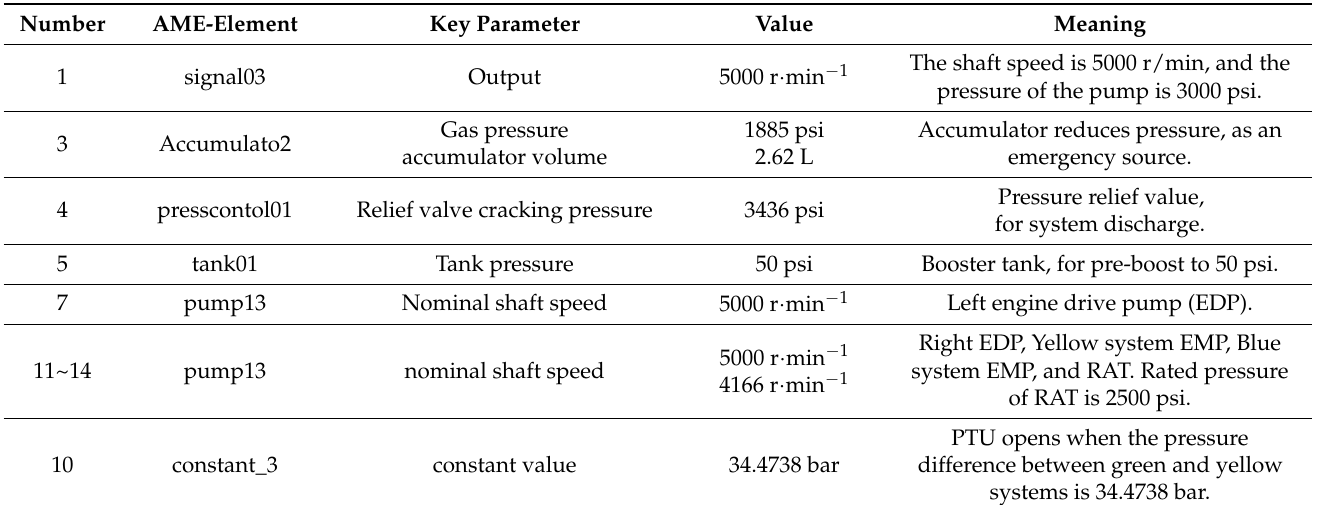
Table 1. Simulation parameters of the aircraft hydraulic system.